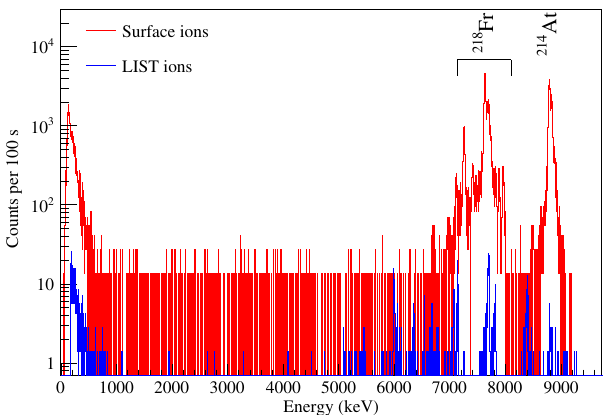
FIG. 4. Comparison of the α -decay energy spectra for A ¼ 218 obtained in two different runs using the LIST to suppress the surface ions (blue lines) and using a standard-surface-ion source (red lines). The same measurement setup is used in both experiments. A beam-gate waiting time for the pulsed-release technique of 100 ms is applied for measurement with the LIST and 200 ms for the measurement with the surface-ion source. Both data sets are normalized to counts per 100